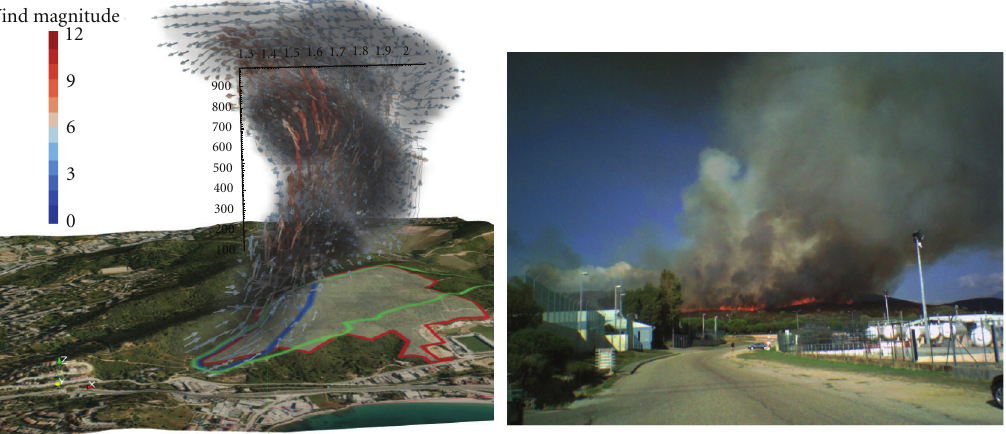
Figure 10: Case 1: Simulated and observed plume. Simulated plume is given 1 h after the fire ignition (the blue contour represents the fire front at that time) as the observation was taken approximately at the same